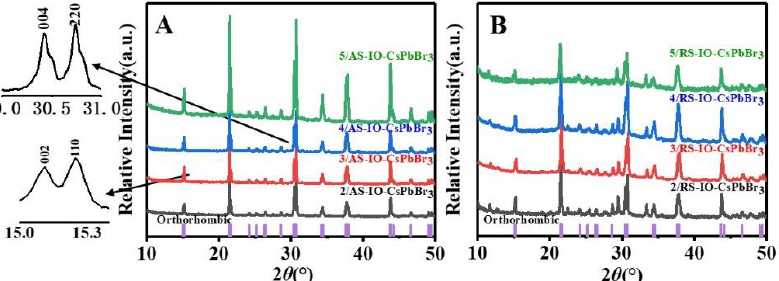
Figure 3. Powder X-ray diffraction (PXRD) patterns of the AS-IO-CsPbBr 3 ( A ) and RS-IO-CsPbBr 3 ( B ) powders, prepared using PSs with different diameters and the split diffraction peaks patterns, as shown on the left.